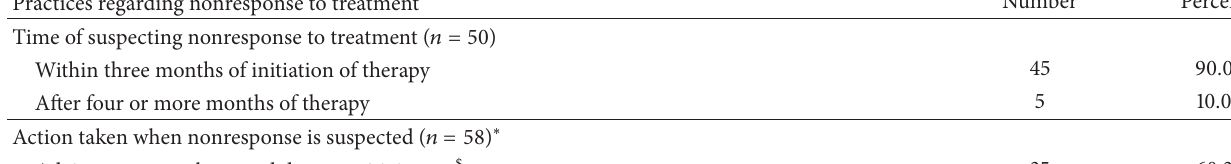
Table 6: Practices of paediatricians regarding nonresponse to anti-TB treatment and diagnosis of drug-resistance among children. Practices regarding nonresponse to